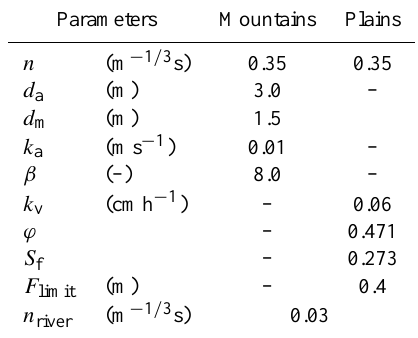
Table 1. Model parameter setting. The entire river basin is catego- rized into two regions: mountain and plain areas. A type S-S (sur- face + subsurface) model is applied to the mountain area with pa- rameters related to soil depths d a and d m , lateral saturated hydraulic conductivity k a and an exponent parameter β related to unsaturated hydraulic conductivity. A type S-I (surface + infiltration) model is applied to the plain area with the G–A model. Their parameters in- clude vertical saturated hydraulic conductivity k v , porosity ϕ and wetting front soil suction head S f , whose values are referred to by Raws et al. (1992). F limit is an upper limit for the cumulative infil- tration depth F in the G–A model. The parameters n and n river are Manning’s roughness coefficients for land surface and river chan- nels. See Sayama et al. (2015) for more details on the equations and their parameters used in the RRI model. Parameters Mountains